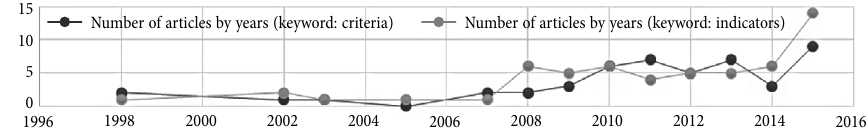
Number of articles by years